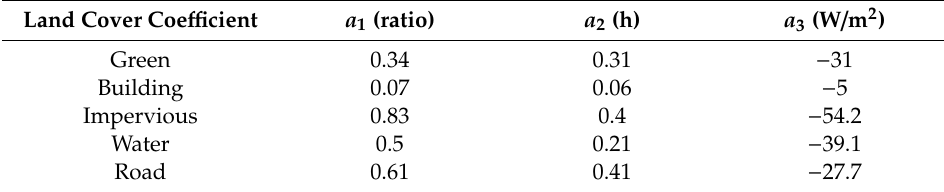
Table A1. Empirical land cover coe ffi cients.